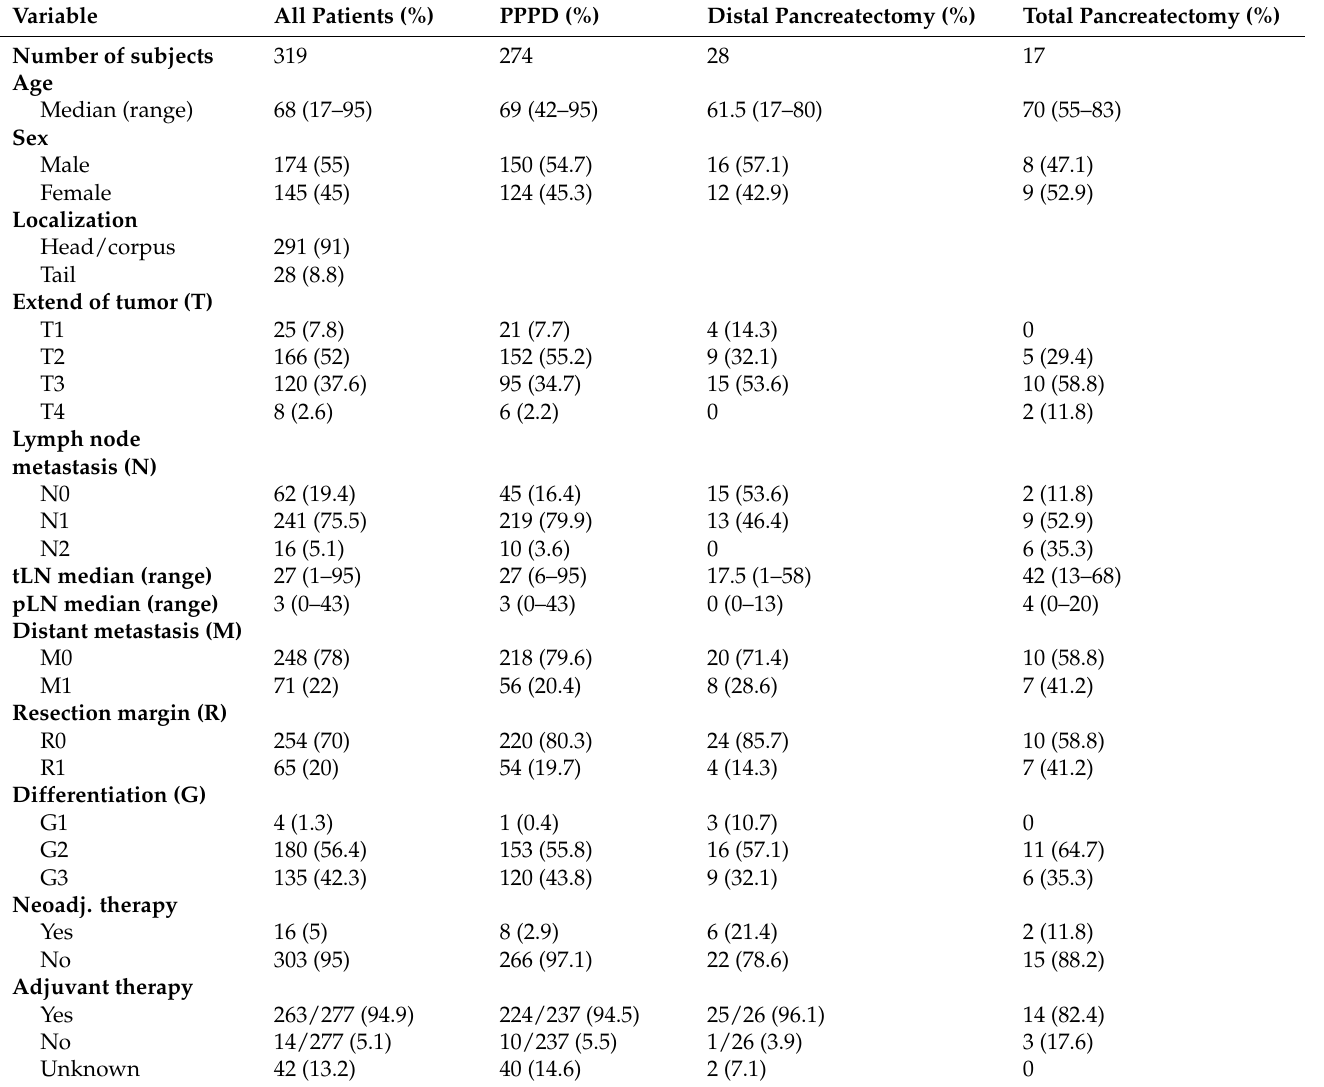
Table 1. Patient